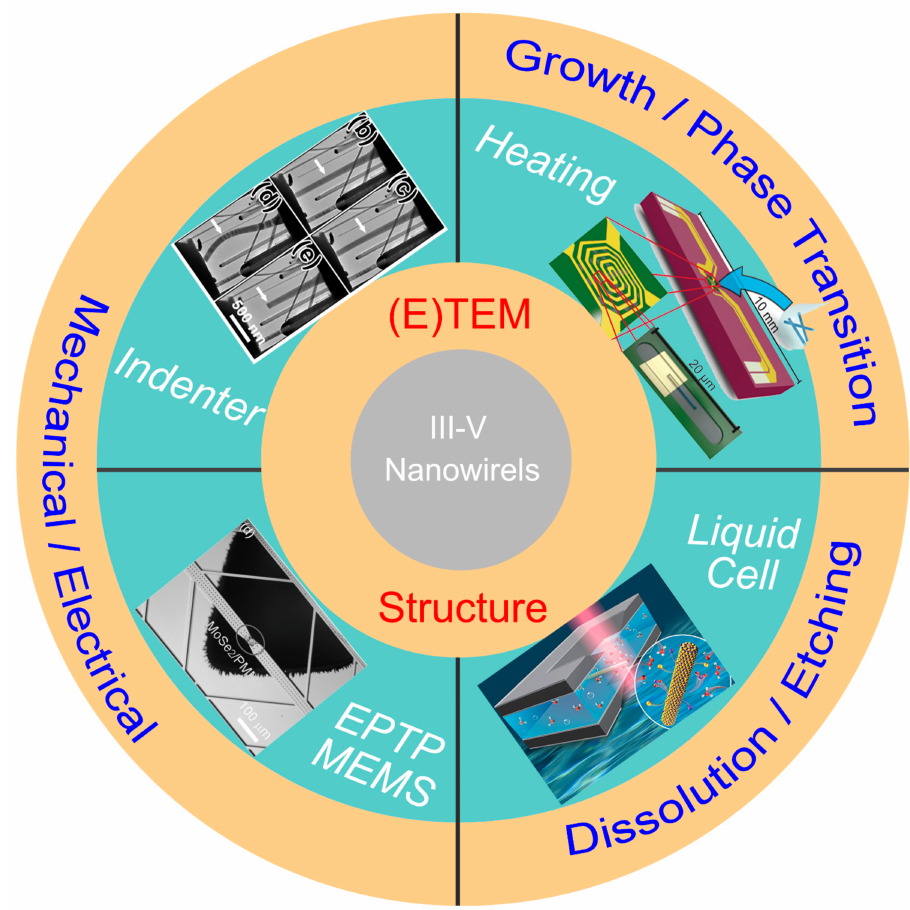
Figure 1. In situ microscopic techniques used in revealing the structure–property relationship of III–V nanomaterials. Top right: reproduced with permission [12]. Copyright 2016, American Chemical Society. Bottom right: reproduced with permission [13]. Copyright 2018, The Royal Society of Chemistry. Bottom left: reproduced with permission [14]. Copyright 2016, WILEY-VCH Verlag GmbH & Co. KGaA, Weinheim. Top left: reproduced with permission [15]. Copyright 2016, American Chemical